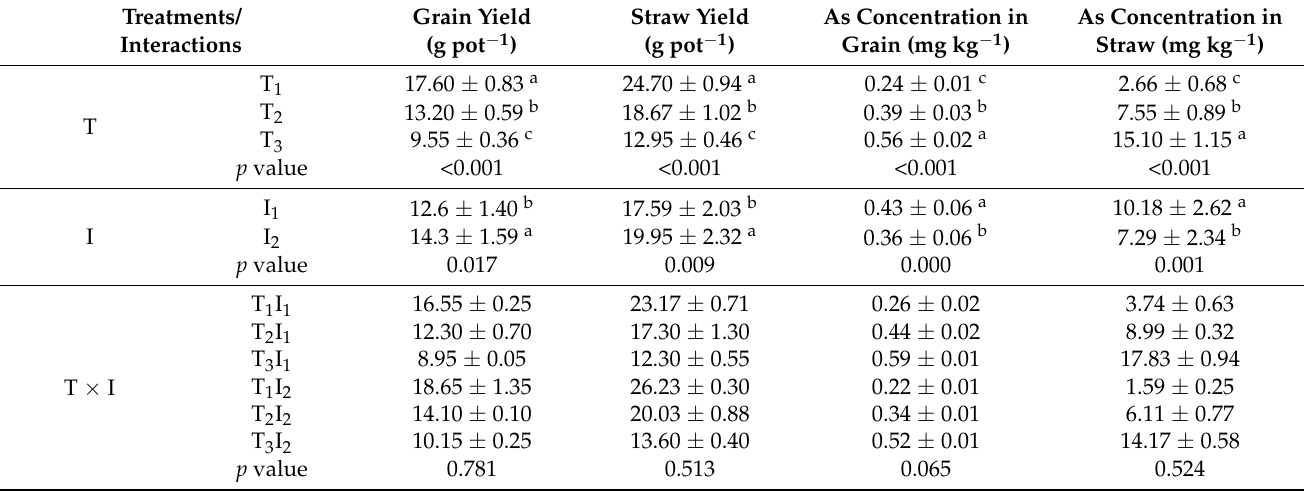
T 1 : 0 mg kg − 1 As, T 2 : 20 mg kg − 1 As, T 3 : 40 mg kg − 1 As; I 1 : continuous flooding (CF), I 2 : alternate wetting and drying (AWD). Averaged values within a column, succeeded by different small letters (a, b, c), differ significantly between different treatments at p < 0.05 significance level. p indicates probability level; SE ( ± ) indicates standard error of